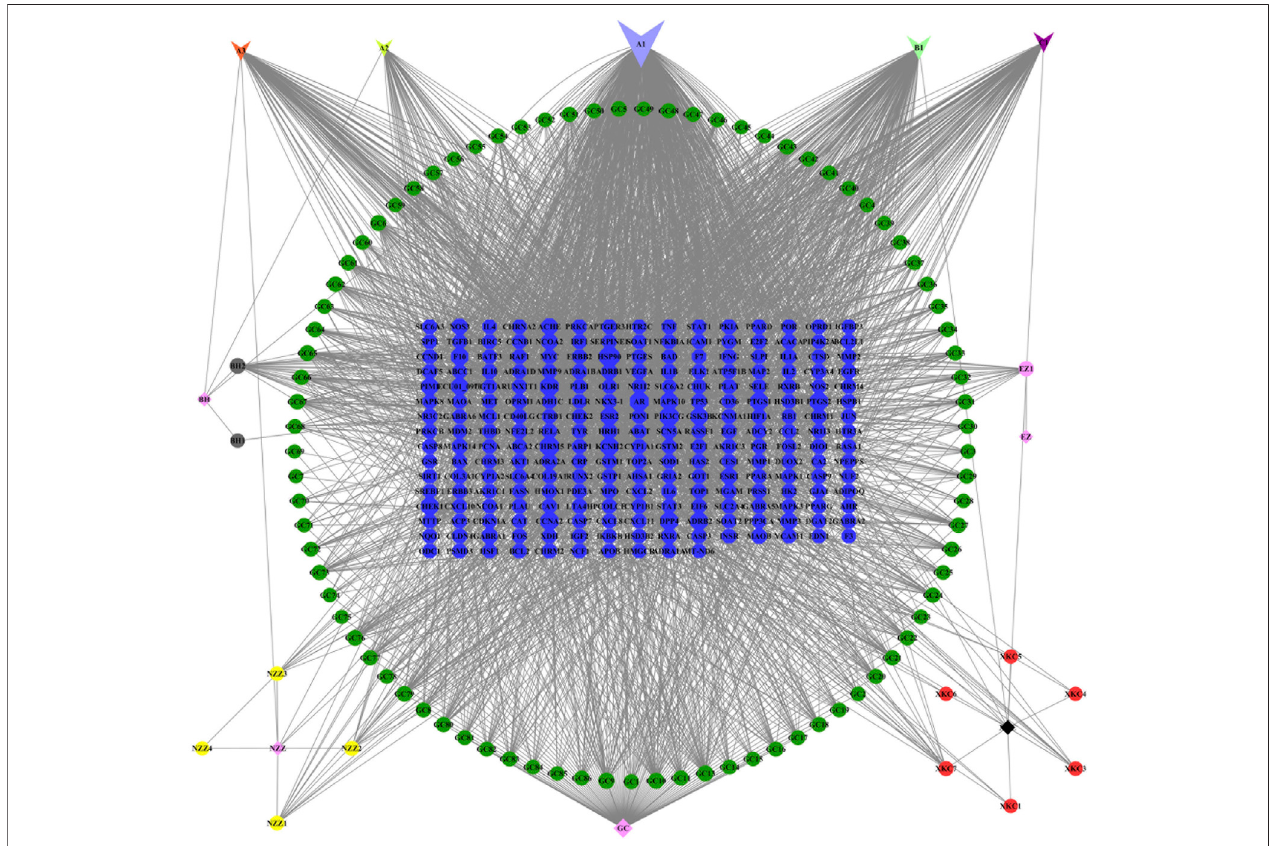
FIGURE 1 | “ ZZXJT active ingredient-target ” network